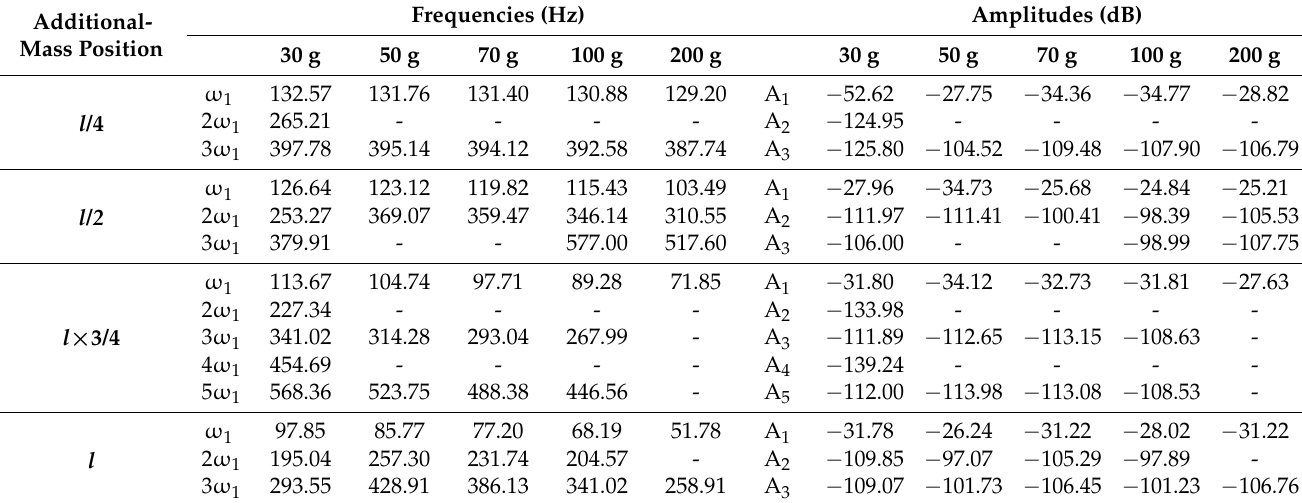
Symmetric additional masses (top to bottom: 30 g, 50 g, 70 g, 100 g, and 200 g) in l. ( d ) Symmetric additional masses (top to bottom: 30 g, 50 g, 70 g, 100 g, and 200 g) in l